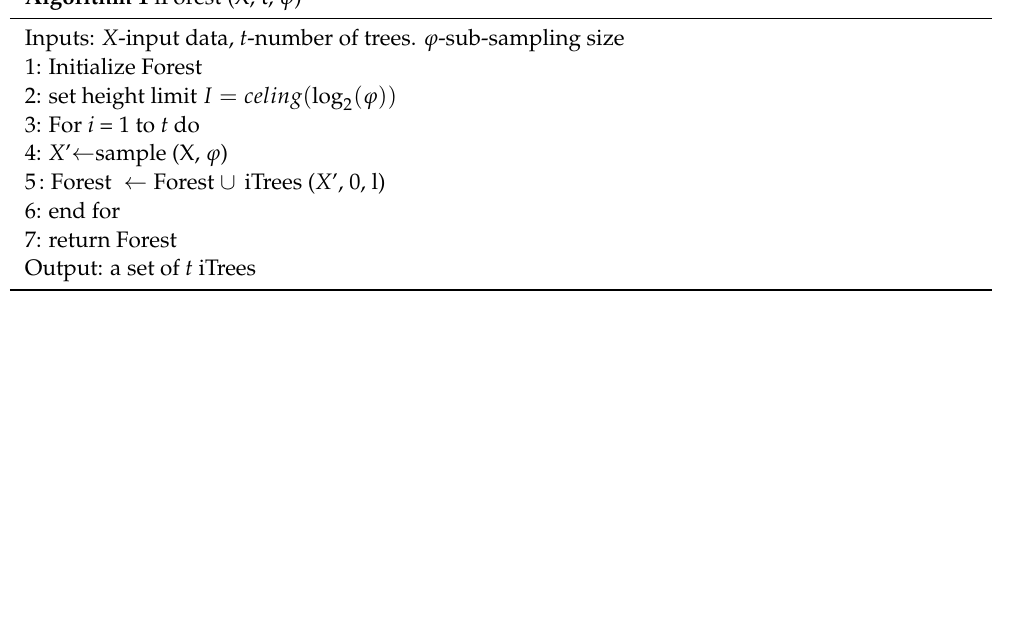
Algorithm 1 i Forest (X, t, ϕ )